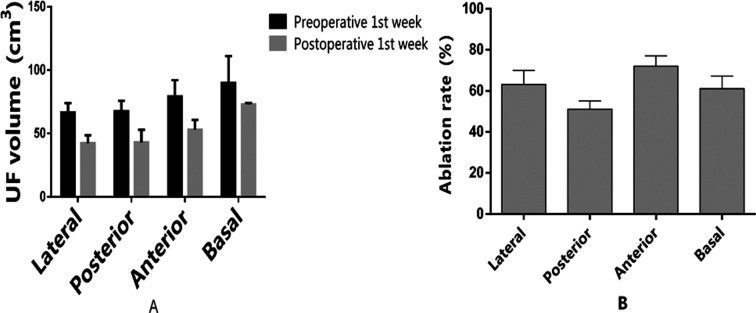
Ablative effects of HIFUA on UFs with different locations. A: UF volumes one week before and after HIFUA; B: ablation rates of UFs with different locations.